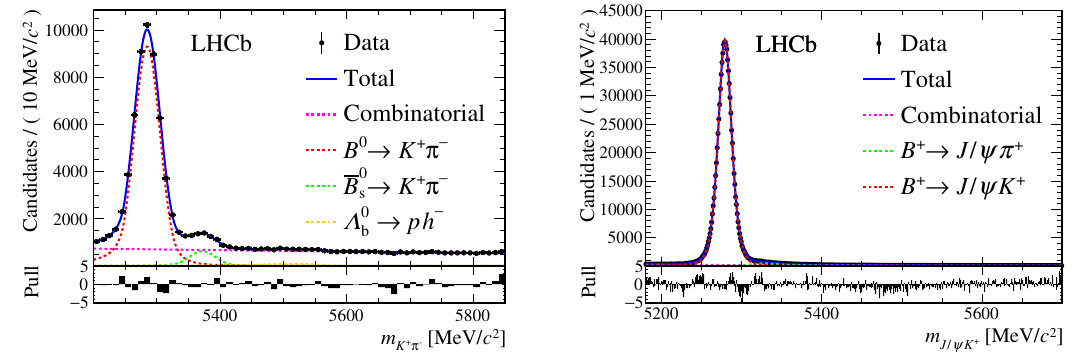
Figure 2 . Invariant mass distributions of the two normalisation channels with (cid:12)t functions superim- posed: (left) B 0 ! K + (cid:25) (cid:0) and (right) B + ! J= K + . Pull distributions are shown below each